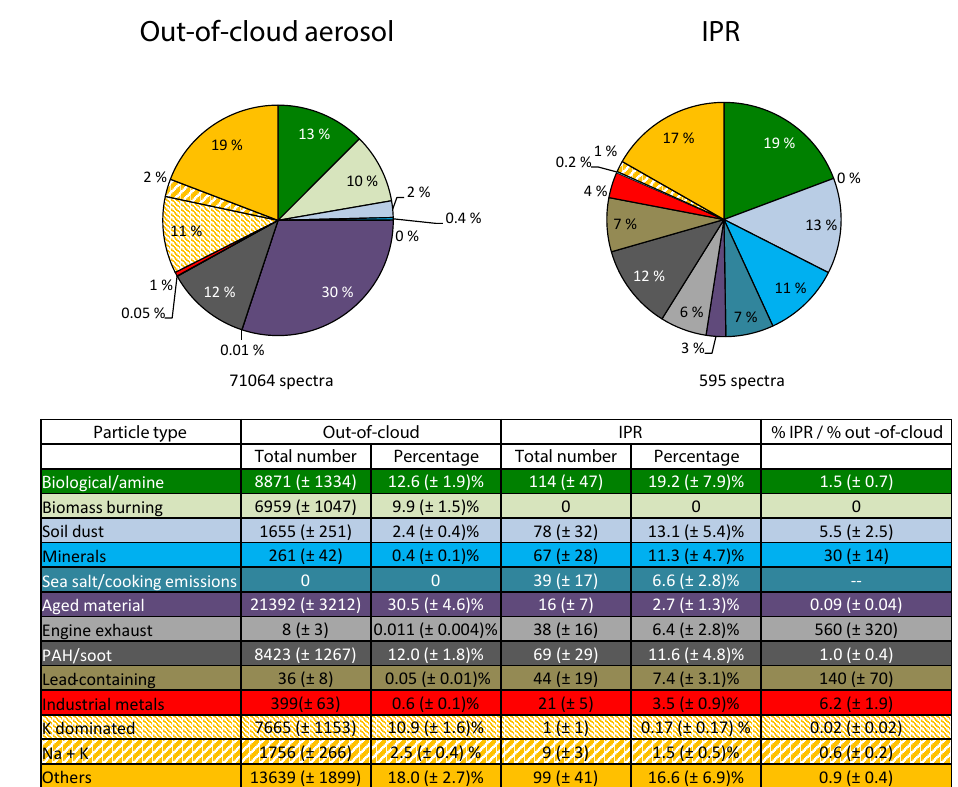
Figure 3. Relative abundance of identified particle types in all out-of-cloud particles (left) and all IPRs (right). The table lists absolute number of particles with uncertainties, percentages and enrichment factor (percentage IPR/percentage out-of-cloud).